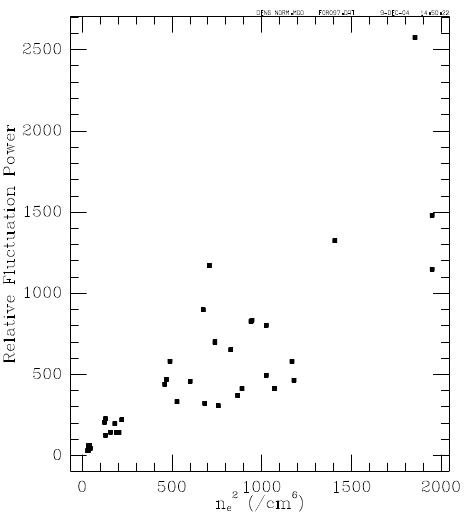
Fig. 6. Dependence of density fluctuations on average density.